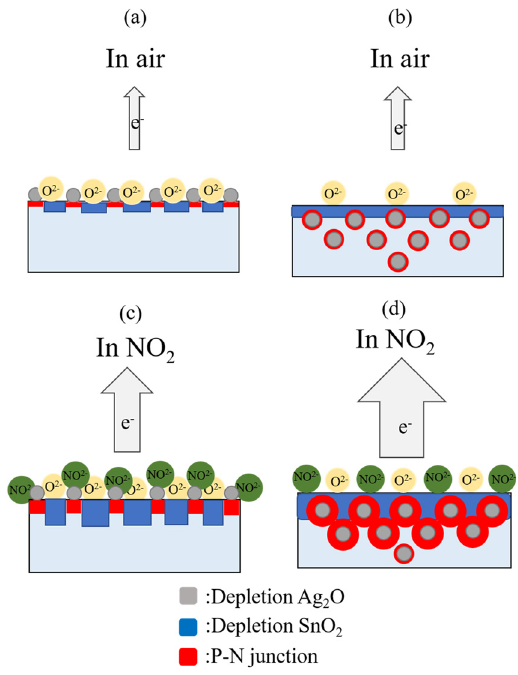
Figure 11: Possible gas sensing mechanisms of SA200 and CSA270 sensors: ( a ) SA200 in air, ( b ) CSA270 in air, ( c ) SA200 in NO 2 gas, and ( d ) CSA270 in NO 2